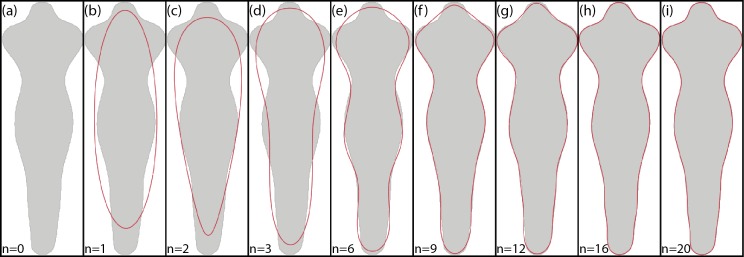
Example of EFD contour reconstruction with different order descriptors (A)–(I), where n represents the number of harmonics used.Generated using the code available in BielStela (2017).